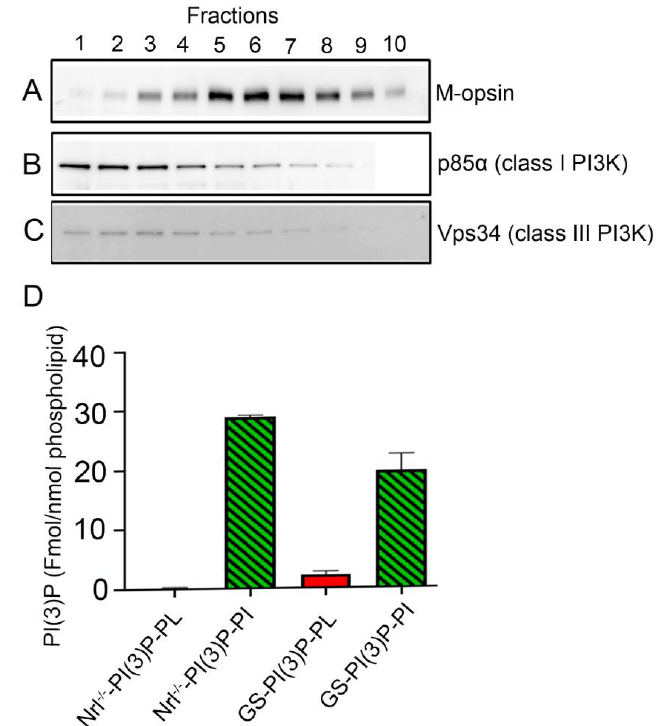
Figure 2. Expression of Vps34 in the cone-dominant retina. Fractions obtained by gradient centrifugation were probed with antibodies to M-opsin ( A ), the p85α subunit of class I were probed with antibodies to M-opsin ( A ), the p85 α subunit of class I phosphoinositide 3-kinase phosphoinositide 3-kinase (PI3K) ( B ), and Vps34 (class III PI3K) ( C ). PI(3)P levels were measured (PI3K) ( B ), and Vps34 (class III PI3K) ( C ). PI(3)P levels were measured from Nrl − / − and ground squirrel from Nrl −/− and ground squirrel retina ( D ). Data are mean ± SEM ( n = 3, Nrl −/− ; n = 6, ground squirrel retina ( D ). Data are mean ± SEM ( n = 3, Nrl − / − ; n = 6, ground squirrel retina). Full-length blots are retina). Full-length blots are presented in the Supplementary Materials. presented in the Supplementary